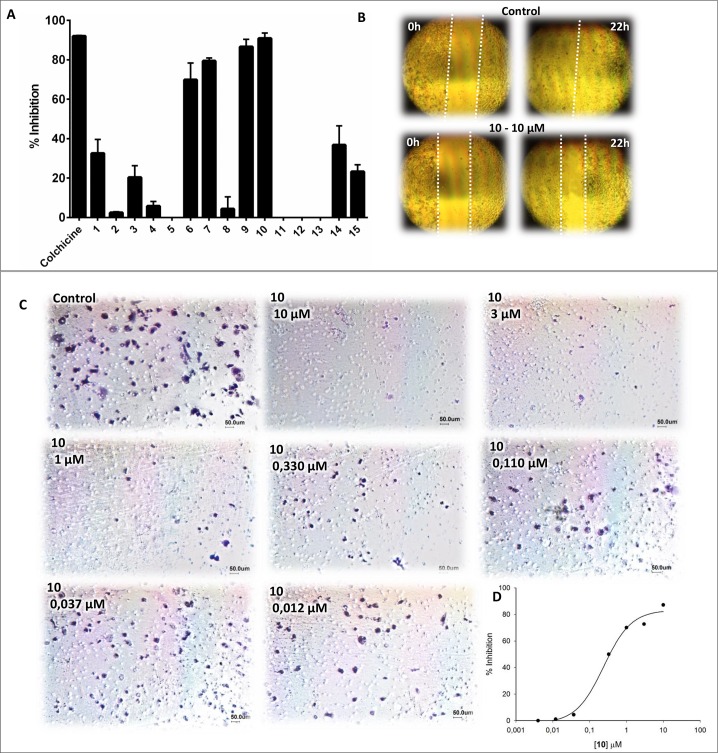
Effects of the acridinones on MDA-MB-231 cell migration.(A), inhibition of wound closure (concentration of 10 μM) (B), pictures of the wound healing assay at 0 h and 22 h for the negative control and 10 (C), representative pictures of migrated cells in a Boyden chamber assay for the negative control and 10 in different concentrations (D), a representative IC50 curve for the antimigratory response against 10.